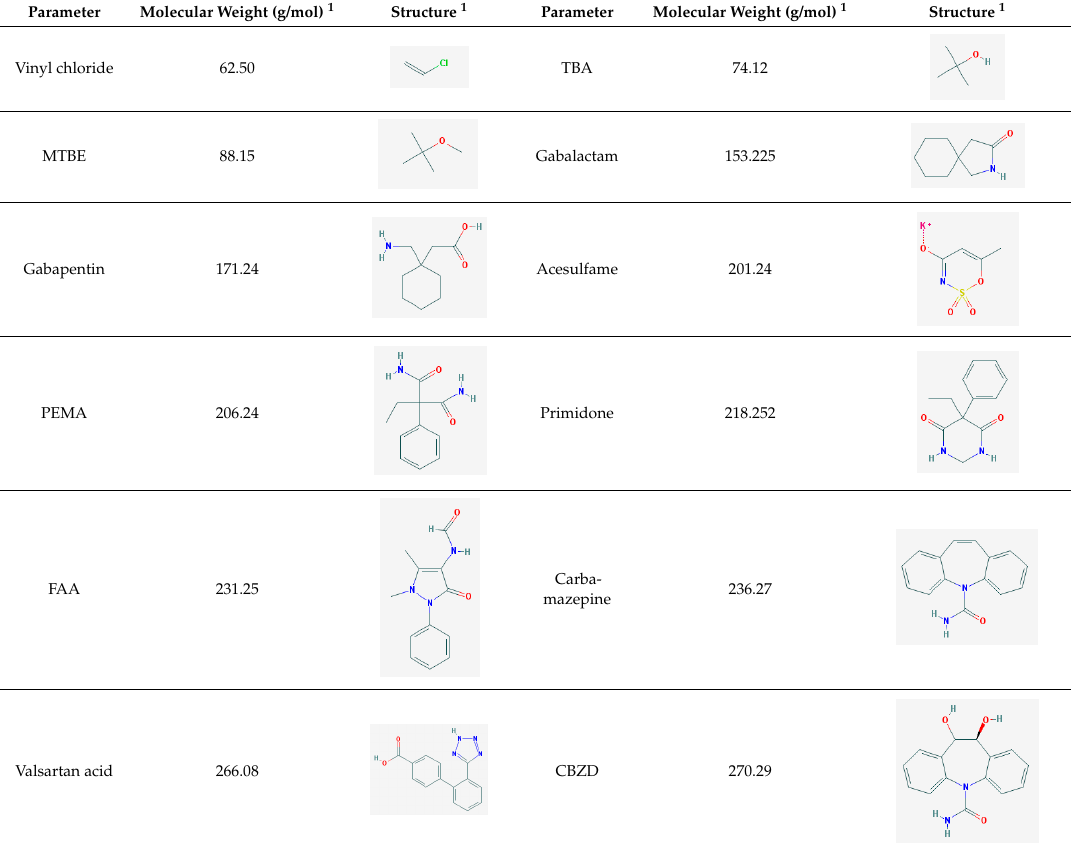
Table A4. Analyzed organic micropollutants, molecular weight, structure. Parameter Molecular Weight (g/mol) 1 Structure 1